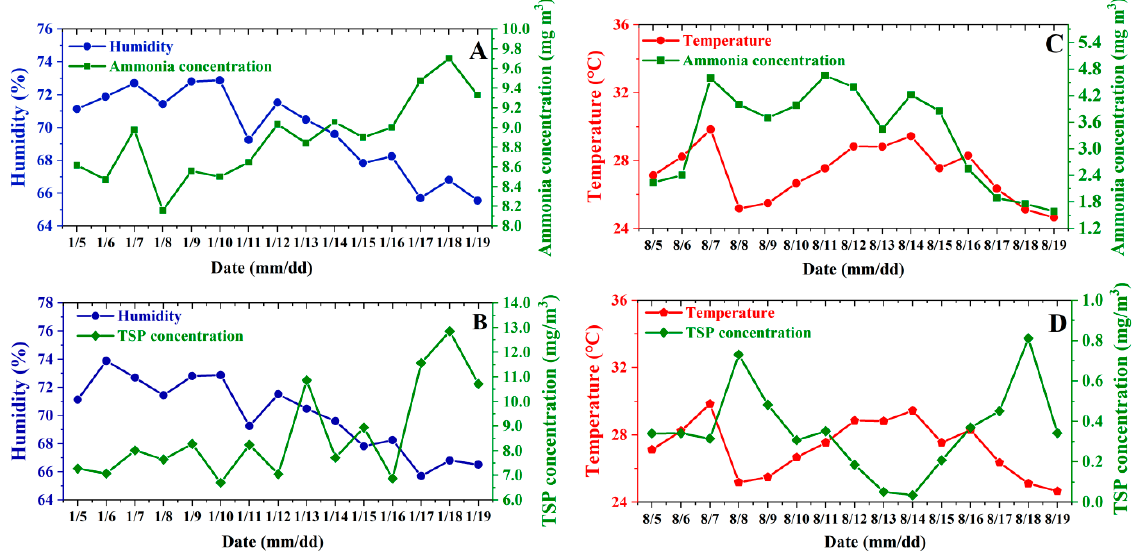
Figure 7. Correlations of aerial pollutant concentration and relative humidity of the pig-fattening house during winter weeks ( A , B ) and summer weeks ( C , D ).